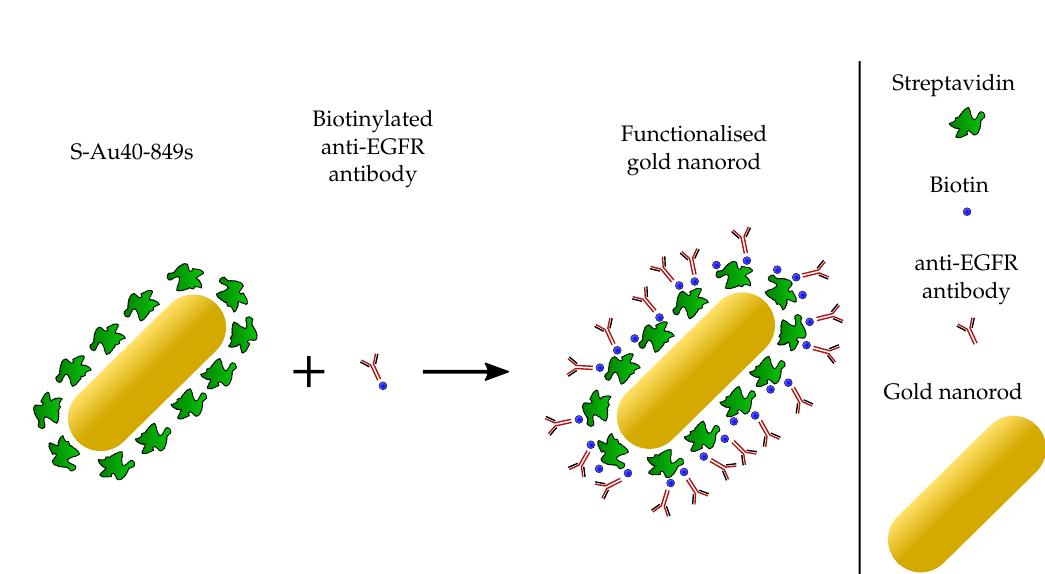
Figure 2. The biotinylated anti-EGFR antibodies exhibit high affinity to the streptavidin proteins that are already conjugated to the